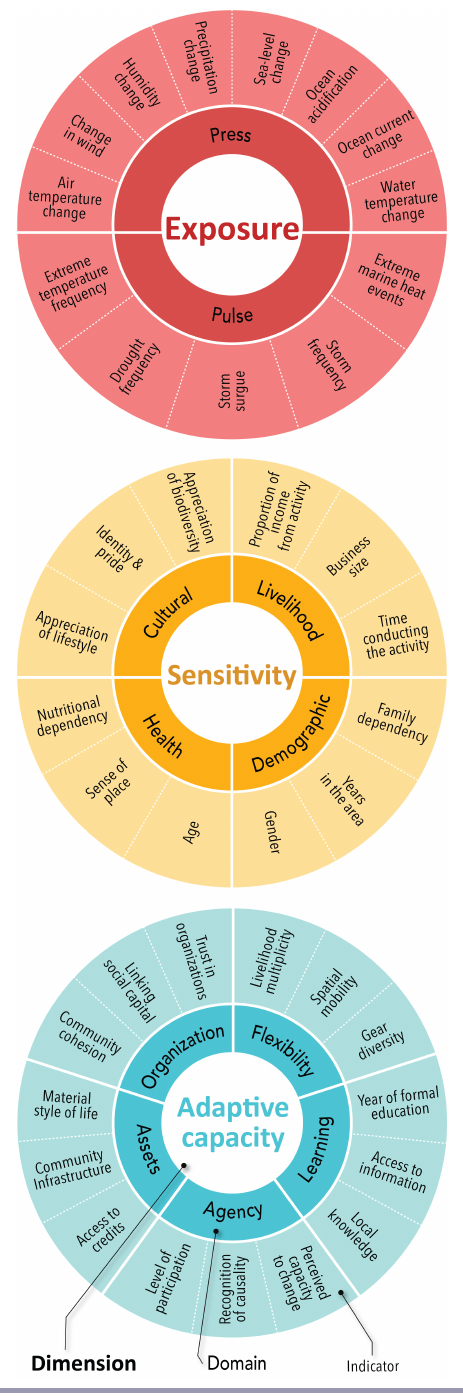
Fig. 2 . Conceptual diagram illustrating the three proposed nested layers for theoretically and contextually grounded vulnerability assessments: dimensions (inner circle), domains (middle circle), and indicators (outer circle). Examples of domains and indicators are modified from (Marshall et al. 2017, Cinner et al. 2018, Day et al. 2019) and describe the social vulnerability of resource-dependent communities to climate